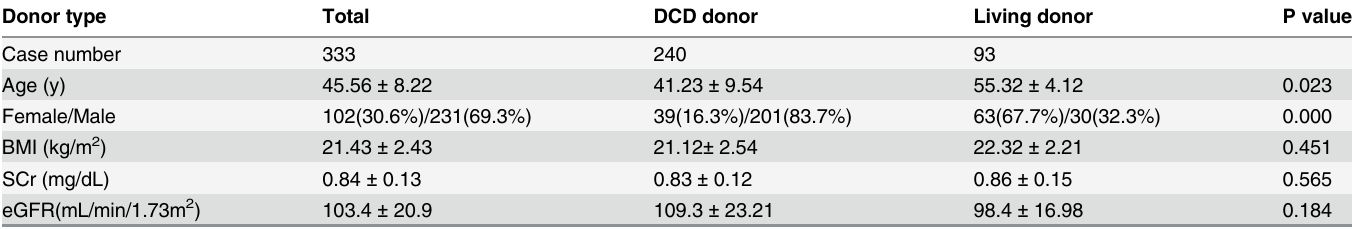
Table 2. General information of recruited donors. Abbreviations as in Table 1. Two types of donors we recruited are basically comparable in renal func- tion, age and BMI. Donor